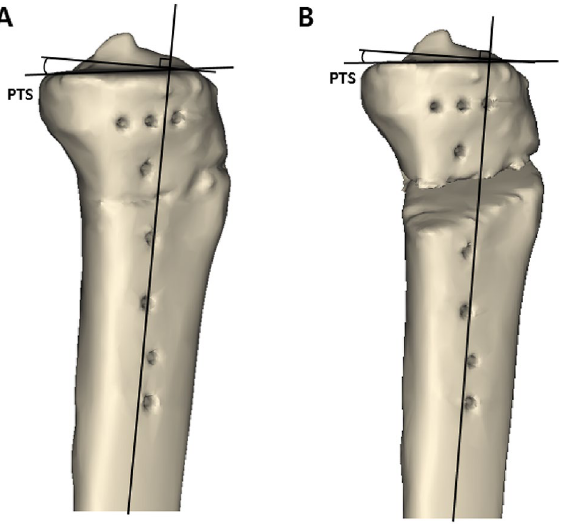
Figure 5. Measurement of the posterior tibial slope. In a true lateral position, the image of the 3D tibial model was captured and the posterior tibial slope was measured. The medial tibial plateau line and the line perpendicular to the line bisecting the tibial shaft were drawn. Posterior tibial slope was defined by the angle formed by these two lines. ( A ) Posterior tibial slope of the preoperative original tibia. ( B ) Posterior tibial slope of the virtually osteotomized tibia. PTS = posterior tibial slope. These figures were created using the Mimics software (version 17; Materialise, Leuven, Belgium).